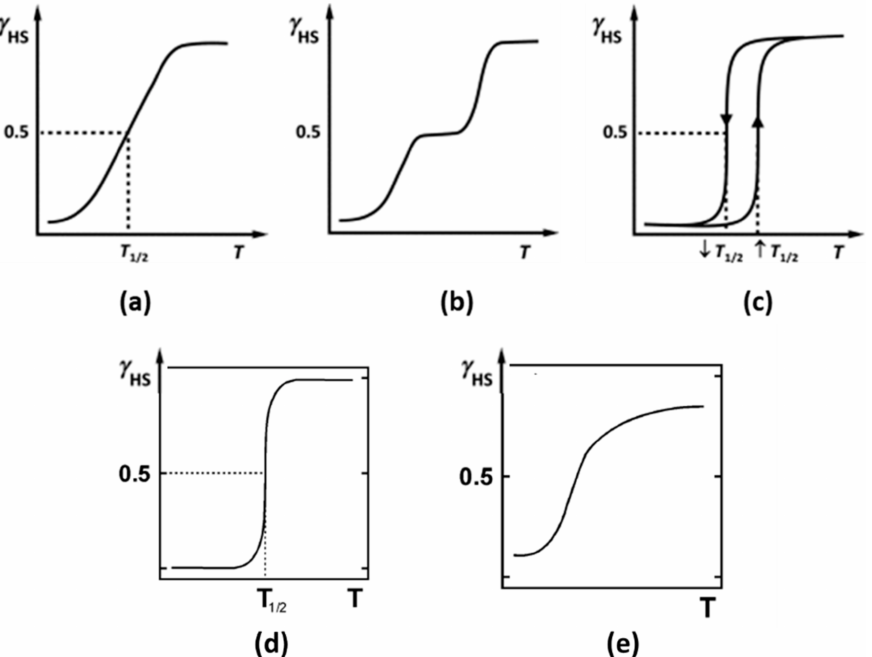
Figure 2. Sketch drawing of a typical gradual ( a ), two-step ( b ), with a hysteresis loop ( c ), abrupt ( d ), incomplete ( e ), and temperature-induced spin-crossover